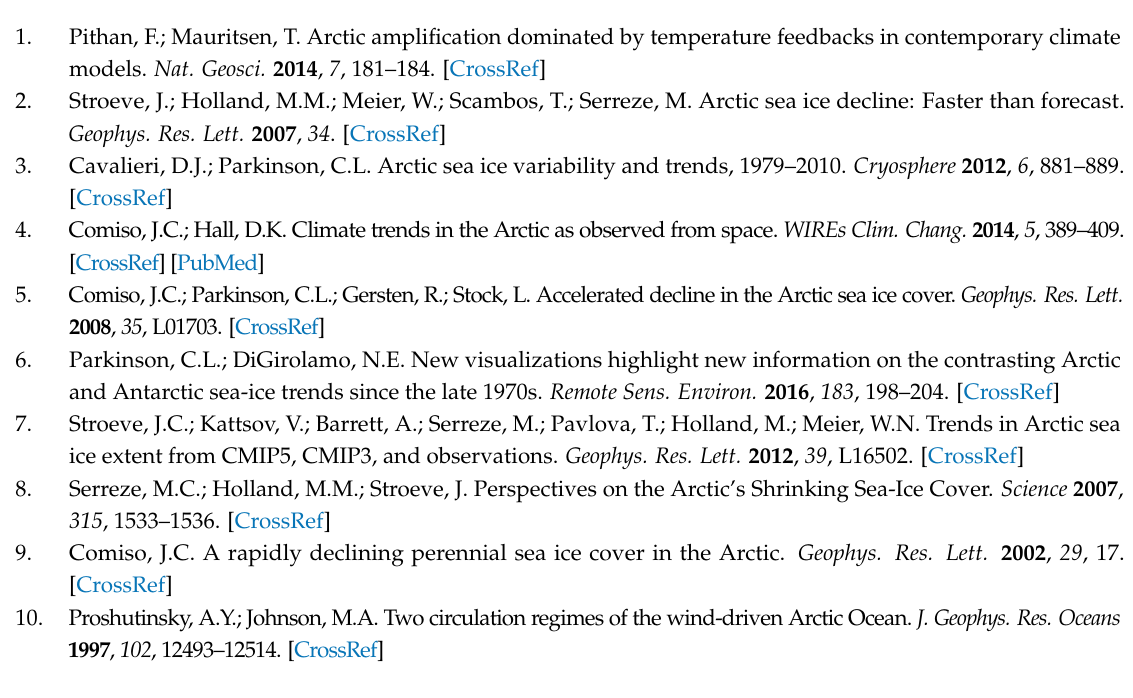
Figure S1. AR frequency over the area between 55 ◦ and 65 ◦ N over the period 1997–2014: The blue line represents the number of ARs for every longitude and the box embedded in the plot shows the spatial distribution of the ARs. Reddish colors represent areas with higher AR frequency and bluish colors those with lower. The red lines depict the 75th percentile of the